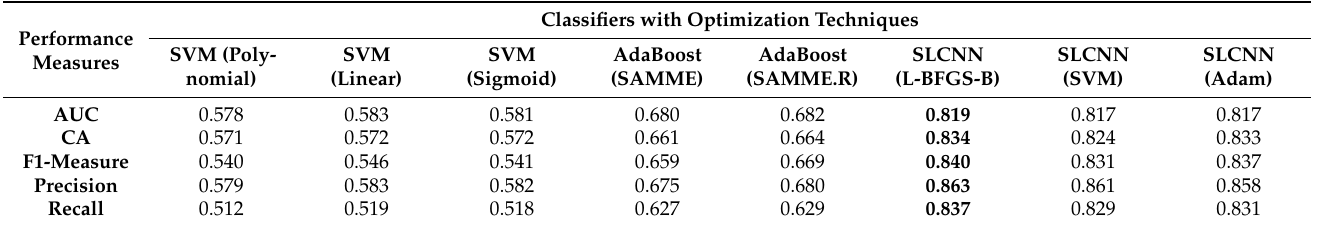
Figure 11 represents the performance measures of SVM, AdaBoost, and SLCNN graphically using the Guardian financial news related dataset, classified according to four sentiment classes during the testing phase.